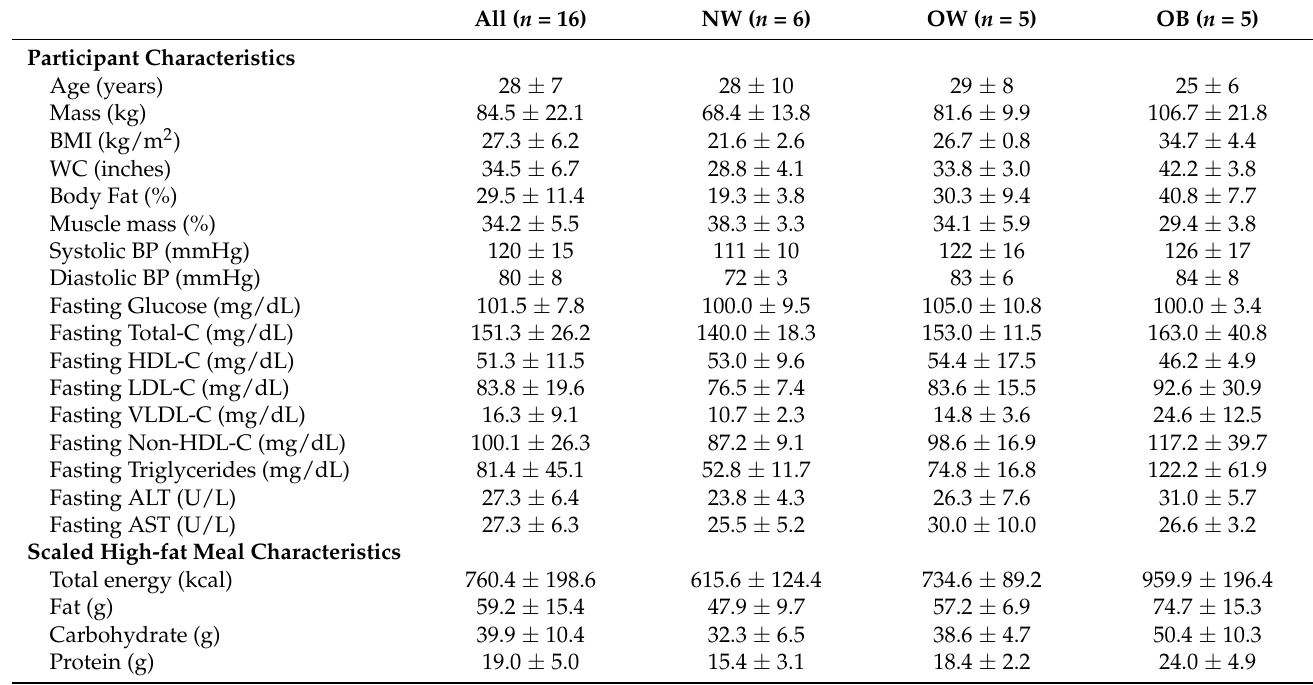
Table 1. Participant and Meal Characteristics.